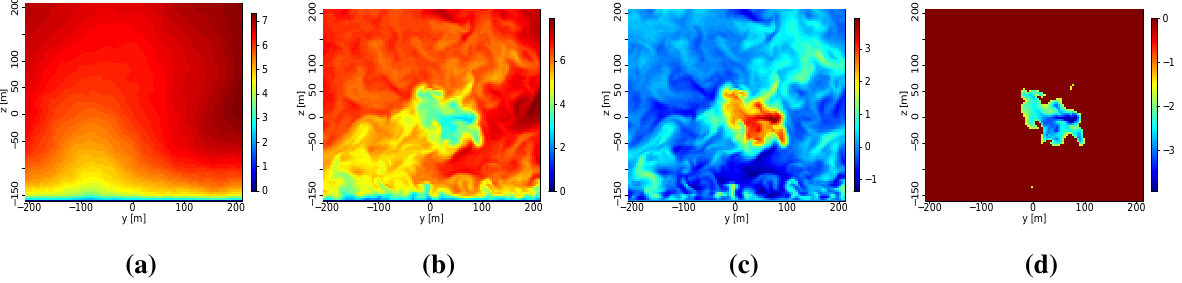
Figure 1. ( a ) Time-averaged velocity field without turbine; ( b ) wake u ( y, z ) at distance x = 4 D and t = 500 s; ( c ) wake after subtracting the time-averaged velocity field without the turbine; ( d ) wake after applying the